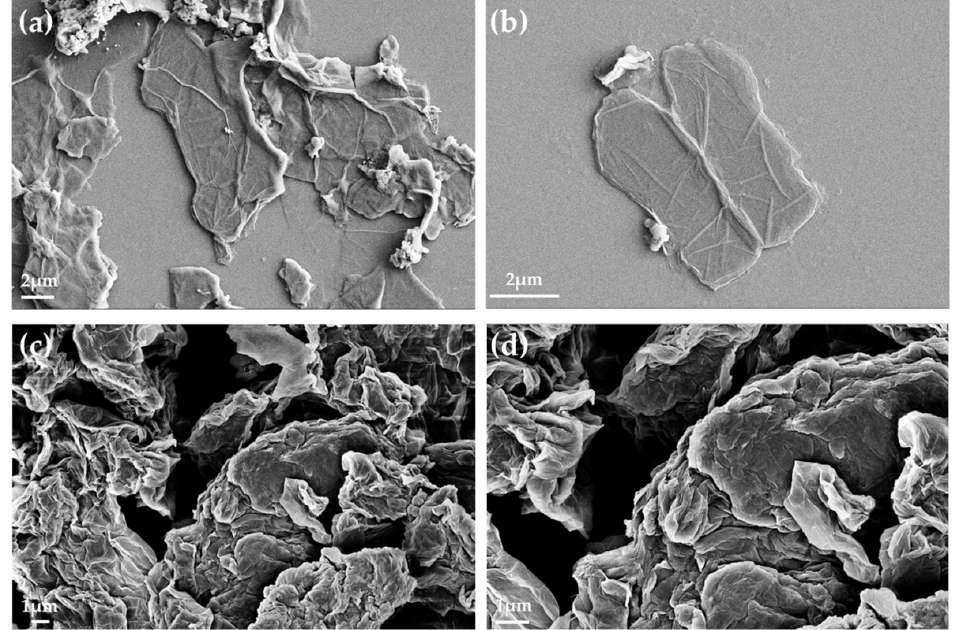
Figure 9. SEM images for GO ( a , b ) and GO-PA ( c , d ).